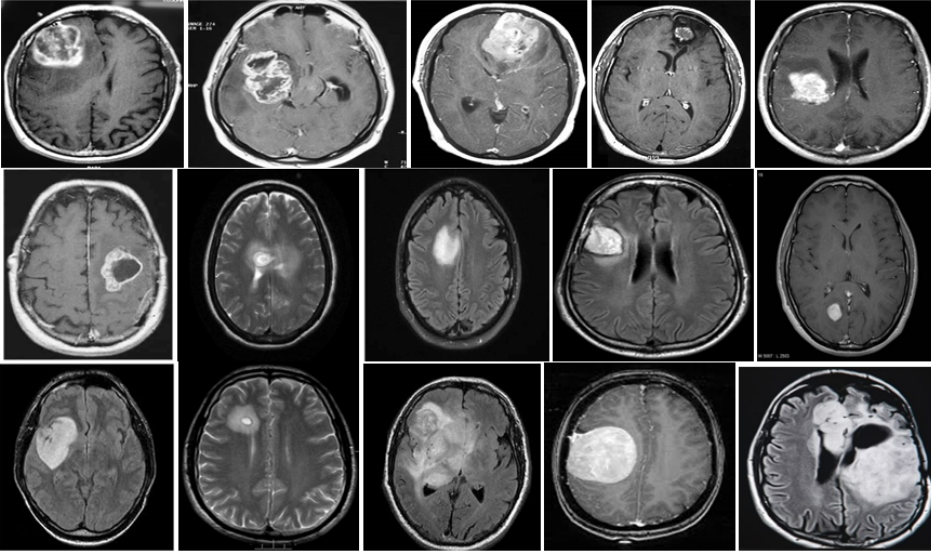
Figure 3. Abnormal brain